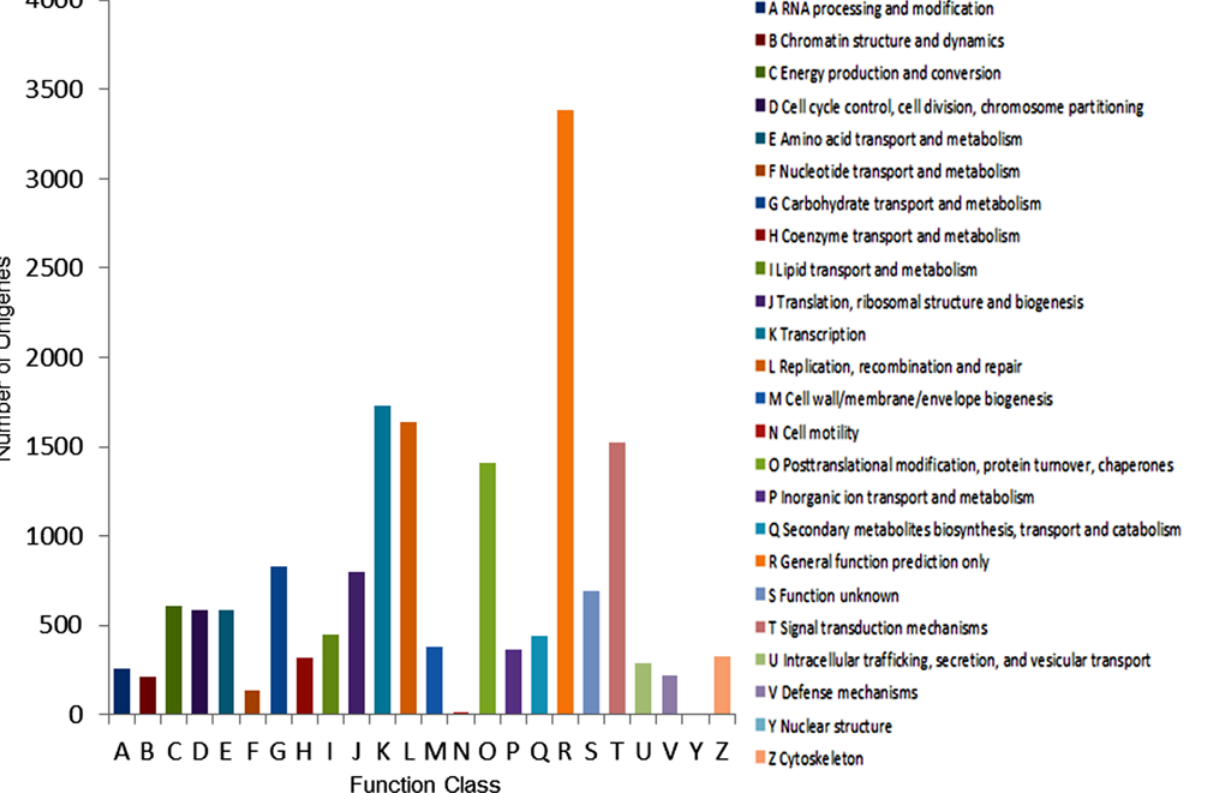
Fig 5. COG function classification of ‘ Hangbaishao ’